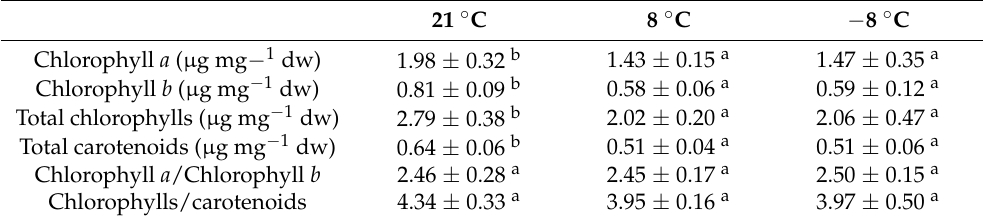
Table 2. Content of pigments in flat leafe kale ( B. oleracea var. acephala ) sprouts affected by different temperatures. Value marked with different letters are significantly different at p <